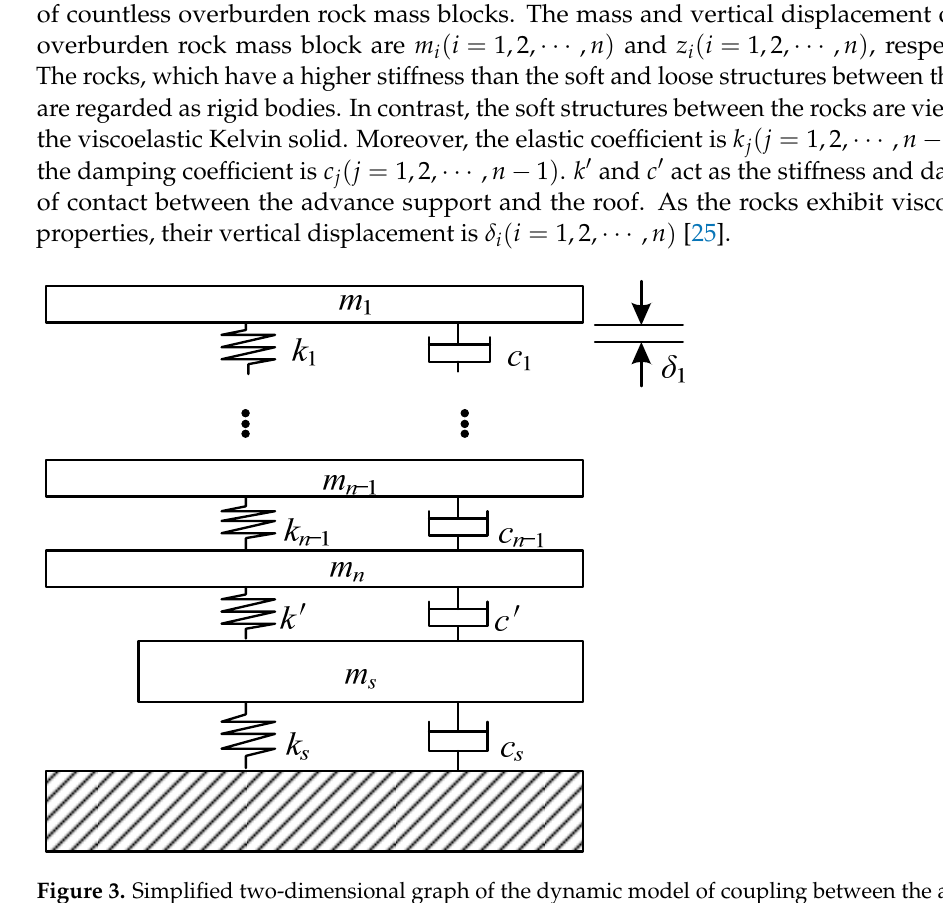
Figure 3. Simplified two-dimensional graph of the dynamic model of coupling between the advance support and the